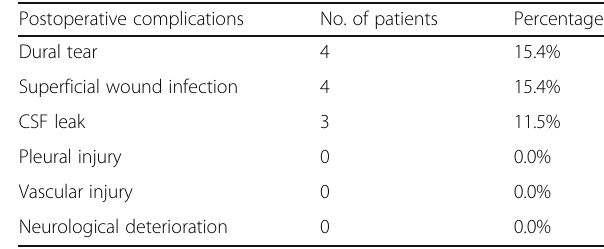
Table 3 Postoperative complications in our